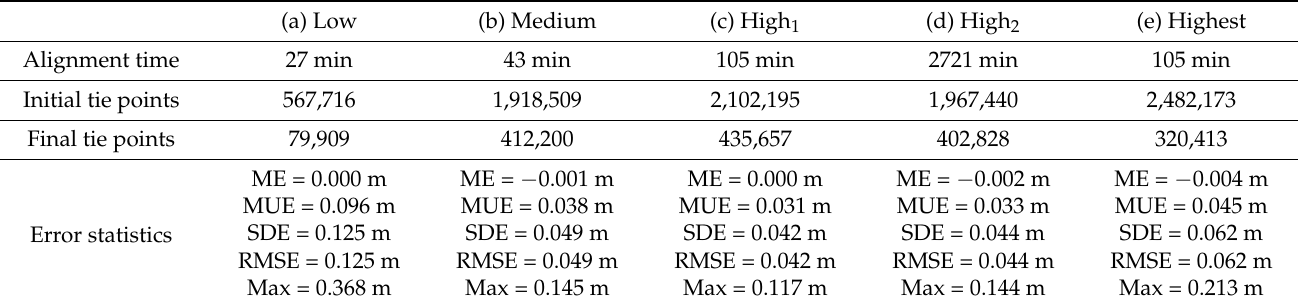
Table 6. Effect of changing the image alignment accuracy setting during sparse DEM reconstruction at La Palue field site in terms of processing time, number of tie points (before and after filtering) and measurement error. Deviations between photogrammetric models (1 m resolution) and GNSS-RTK survey points, from which vertical error statistics are extracted, are presented in Figure